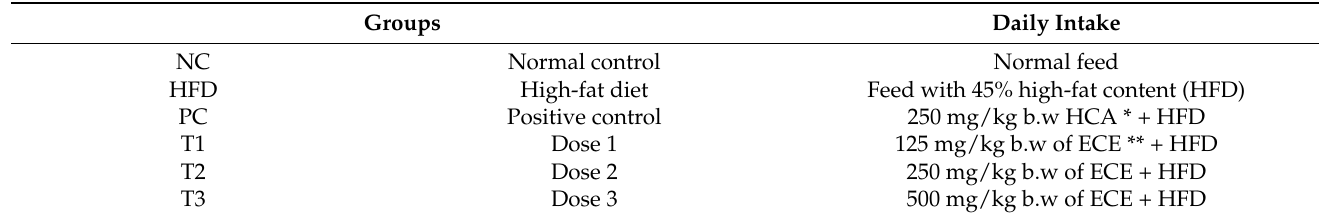
Table 1. Daily dose (per kilogram body weight) intake for each group of rats. Groups Daily